Question: Briefly state, in one sentence, what is plotted here.
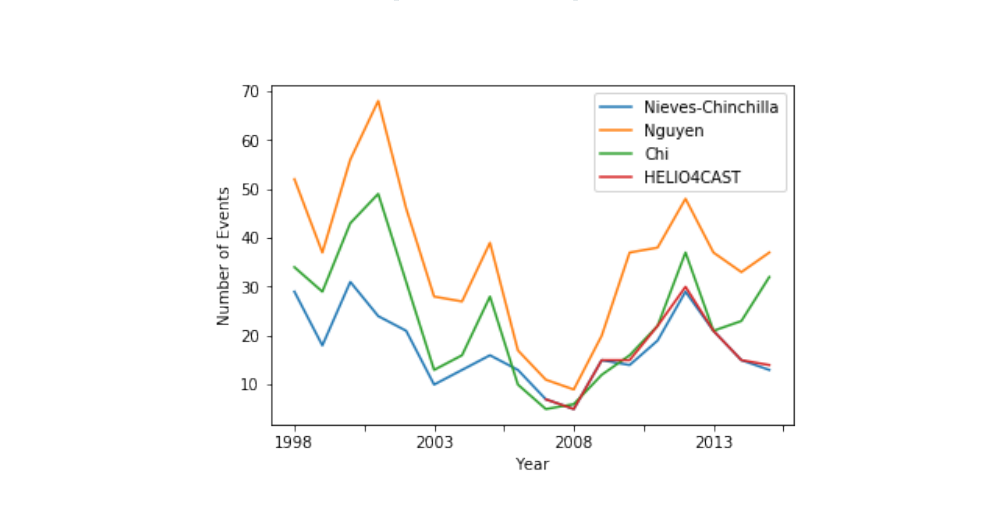
Answer: Comparison of the number of events listed in diﬀerent catalogs: Chi et al. (2016),